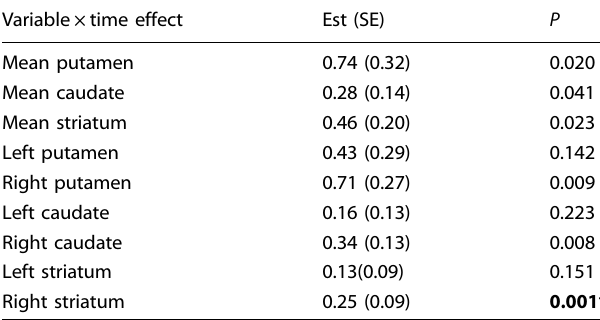
Main and interaction effects of the linear mixed-effects models estimating the longitudinal changes of weight in PD patients as function of longitudinal presynaptic dopaminergic transporter imaging. The model was controlled for age, sex and disease duration. *Signi fi cant p -values after Bonferroni correction for multiple testing.